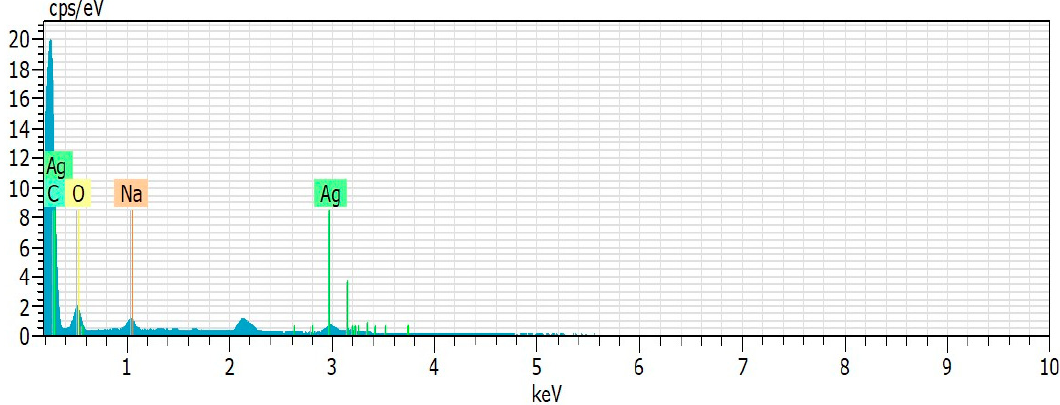
Figure 4. XRD patterns of nanoxylan.